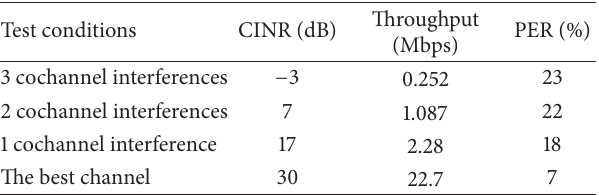
Table 4: Performance evaluation considering different levels of cochannel interference in the 5 GHz